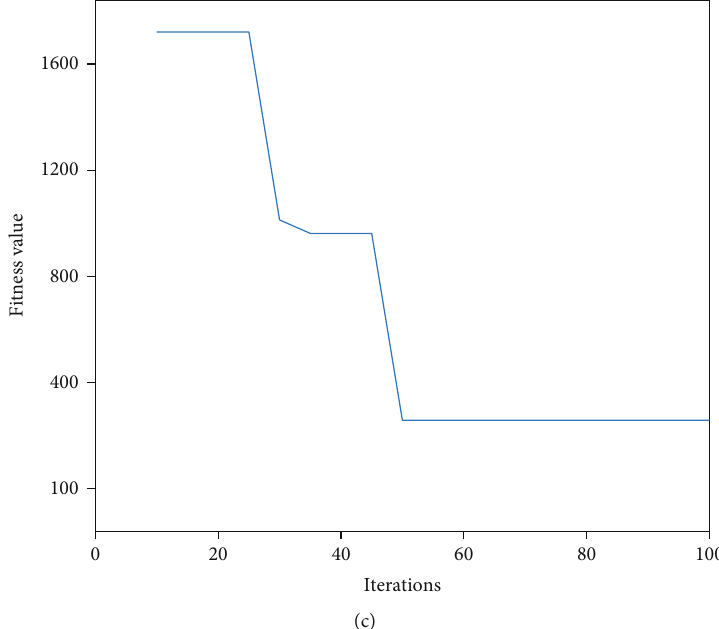
Figure 10: The con fl ict resolution strategies simulation result about the convergence of the APF-GA algorithm: (a) 2 UAVs ’ con fl ict, (b) 6 UAVs ’ con fl ict, and (c) 10 UAVs ’ con fl